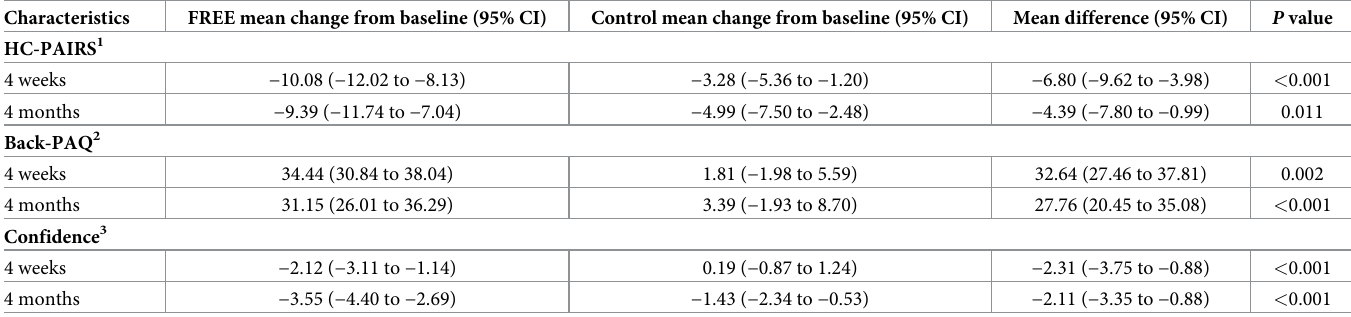
Table 4. Mean GP change scores at 4 weeks and 4 months postintervention